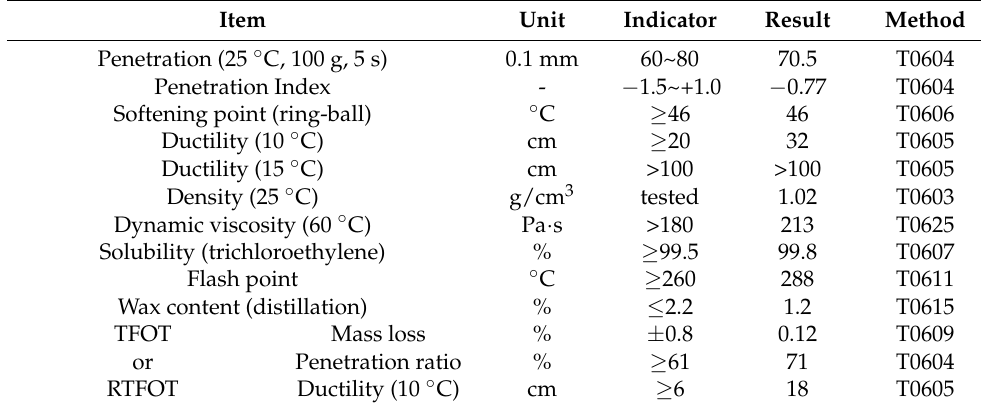
Table 2. Main indexes of No. 70 A-grade matrix asphalt.